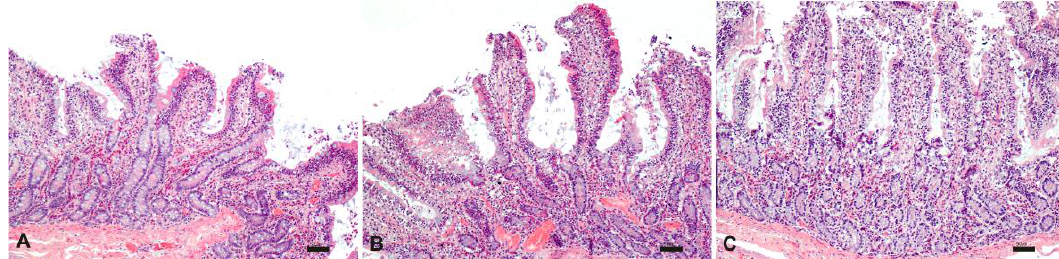
Figure 7. Histological evaluation of intestinal tissue stored at 25°C at 1 h ( A ), 2 h ( B ) and 3 h ( C ). HE; bar: 50 µm.